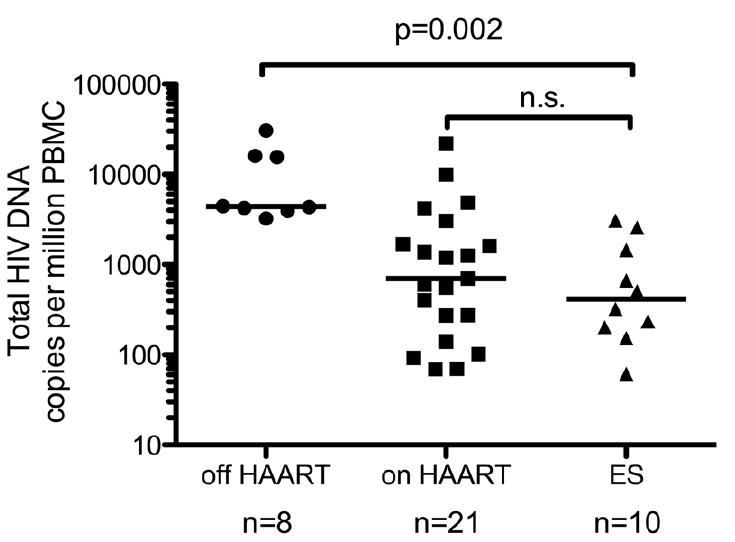
Figure 3. Total HIV DNA is not significantly different in patients on HAART and ES patients. Total HIV DNA was measured by RU5 quantitative PCR in PBMC from 2 non-controllers off and 4 on HAART and elite suppressor patients. Serial two-fold dilutions (from 1e6 to 2.5e5 cells per well) were measured in triplicates for each sample. This was repeated on a separate extraction for all ES. In all cases inhibitors were demonstrated to be absent by dose response in 3 serial two-fold dilutions. Data from 6 off and 17 on HAART patients previously measured was also included for analysis [21,22]. Patients off HAART have higher levels of total HIV DNA than other patient populations. The level of total HIV DNA was not significantly different between patients on HAART and ES, while both were significantly lower than patients off HAART (p=0.002 for both). The line represents the median value.